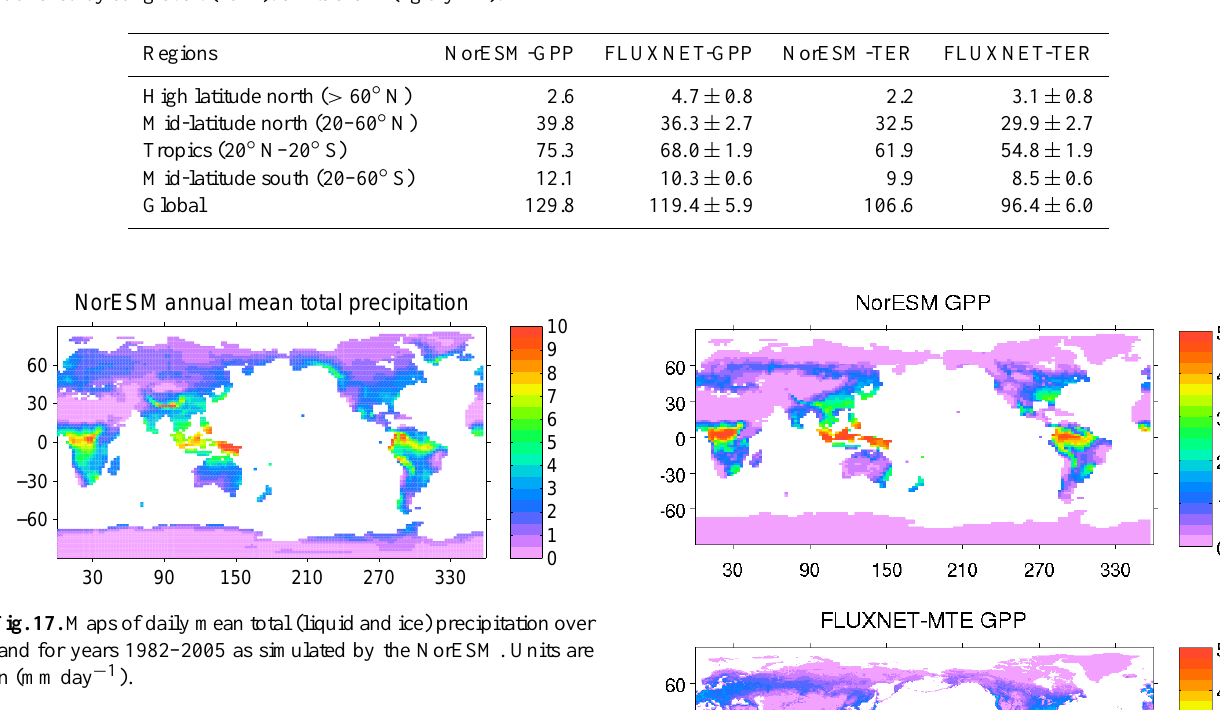
Table 4. Regional and global annual mean gross primary production (GPP) and terrestrial ecosystem respiration (TER) as simulated by the NorESM and estimated from FLUXNET-MTE data. The FLUXNET-MTE uncertainties were estimated based on global mean uncertainties published by Jung et al. (2011). Units are in (PgCyr − 1 ).